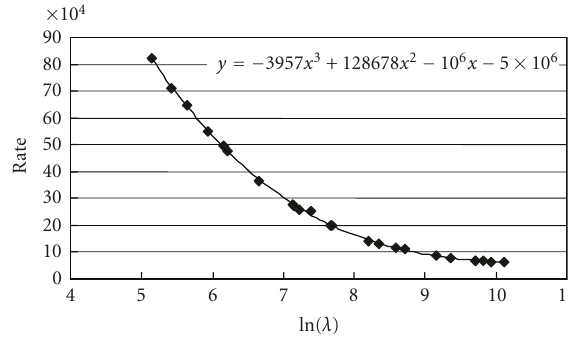
algorithm of 3D-ESCOT, we still need a better model that represents the R-D information of a GOP of coding blocks.